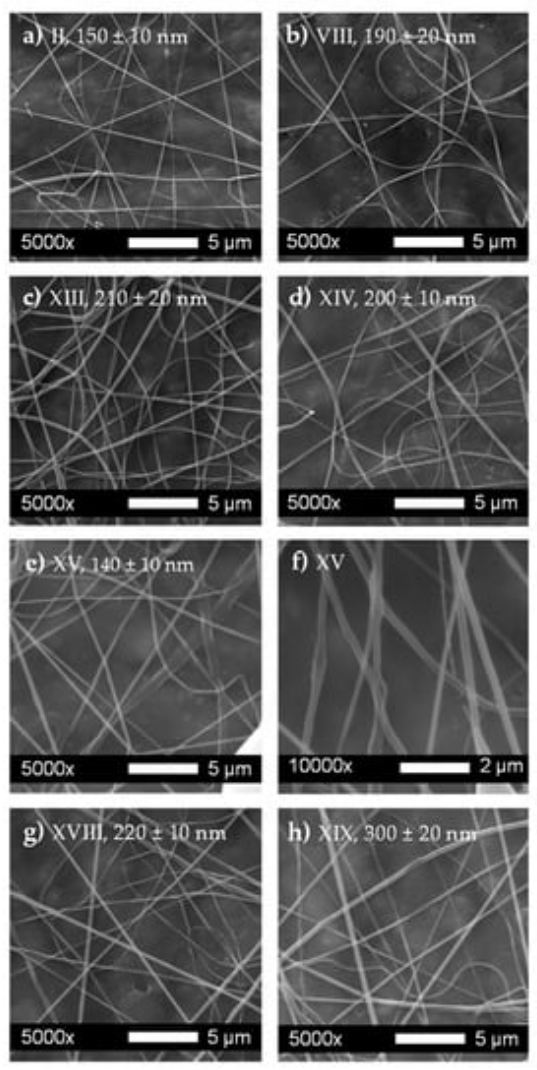
Figure 9. FESEM images of electrospun PCL fibers and their corresponding average diameters; polymer flow rate ( Q p ) and the solvent flow rate ( Q s ) were varied from 0.5 to 5 mL/h. Run II and Run VIII had the same Q p and Q s = 1 mL/h but with different voltages; however, Run XIII corresponds to Q p = 0.5 mL/h and Q s = 5 mL/h, while Run XIV corresponds to Q p = 1 mL/h Q s = 0.5 mL/h. Run XV corresponds to Q p = 1 mL/h and Q s = 1 mL/h. In addition, finally, Run XVIII corresponds to Q p = 3 mL/h and Q s = 1 mL/h, while Run XIV corresponds to Q p = 3 mL/h and Q s = 3 mL/h. Reprinted from ref.